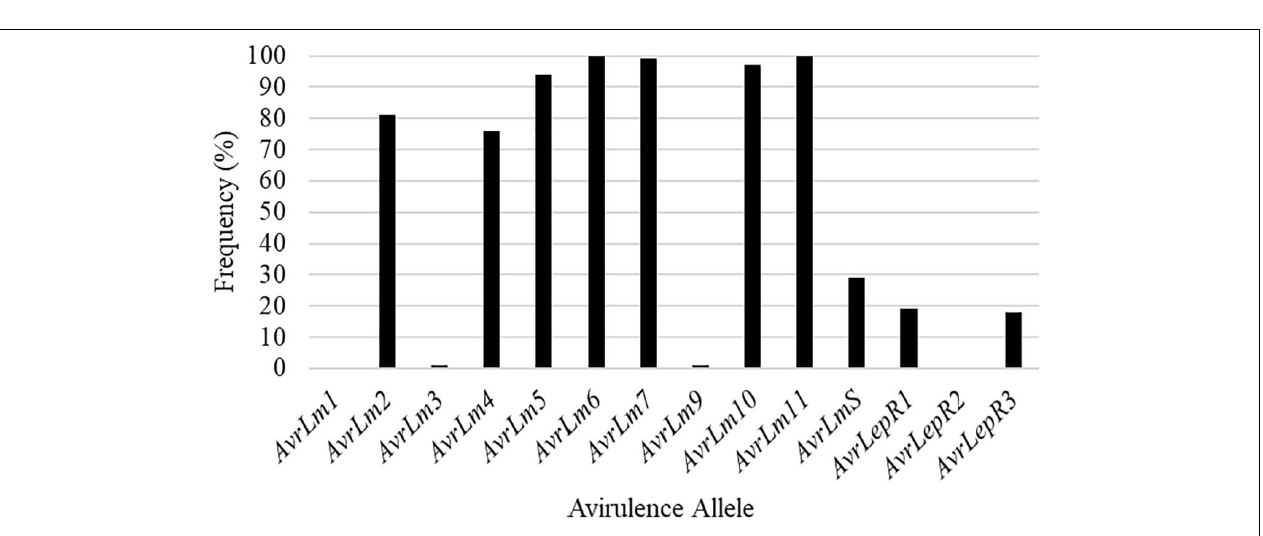
unmasked. Low frequencies of AvrLm1 , AvrLmS , LepR1 , LepR2 , and LepR3 were